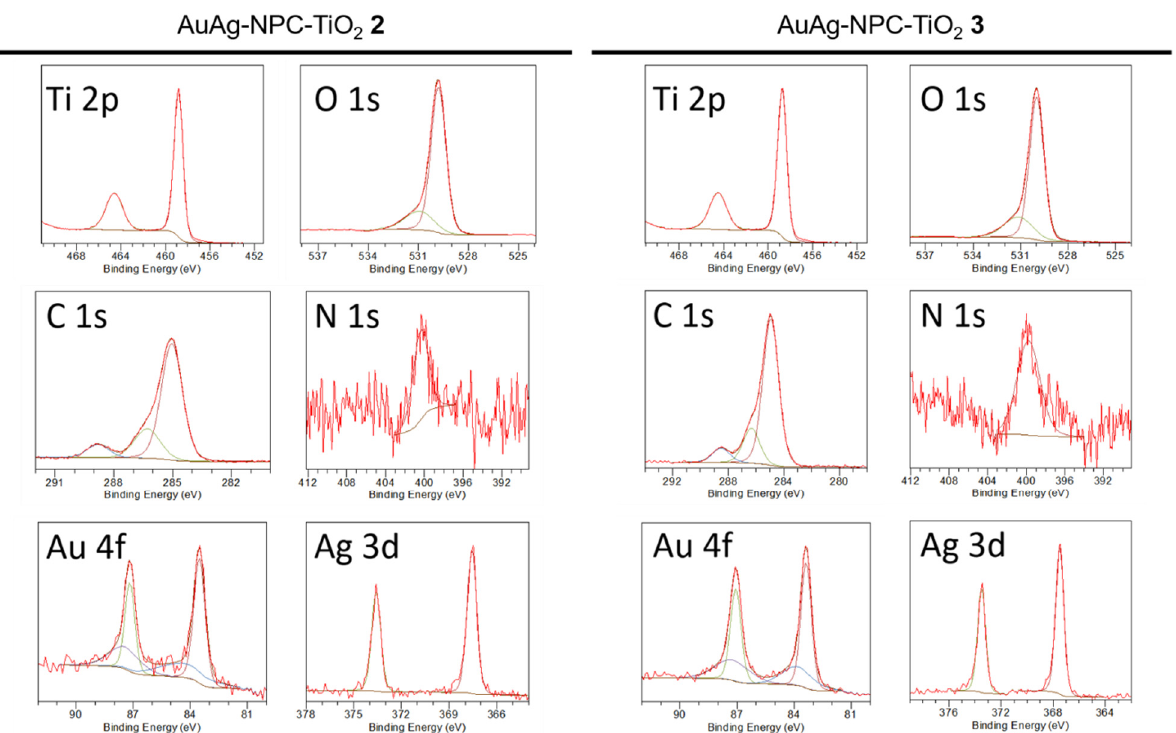
Figure 4. Narrow XPS spectra for Ti 2p, O 1s, C 1s, N 1s, Au 4f and Ag 3d for Au-Ag-NPC-TiO 2 2 and 3 .